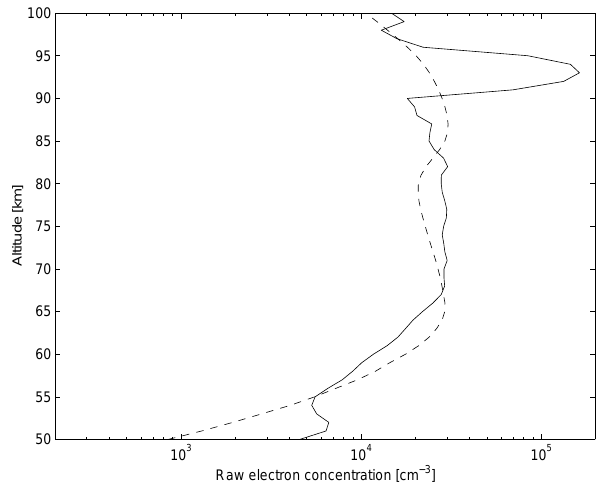
Fig. 5. The electron concentration profiles for the 23 October 1989 as modelled by SIC (the dashed line) and measured by EISCAT (the solid line). The modelled curve is for 12:00UT, while EISCAT curve is an average of the measurements made between 12:00 and